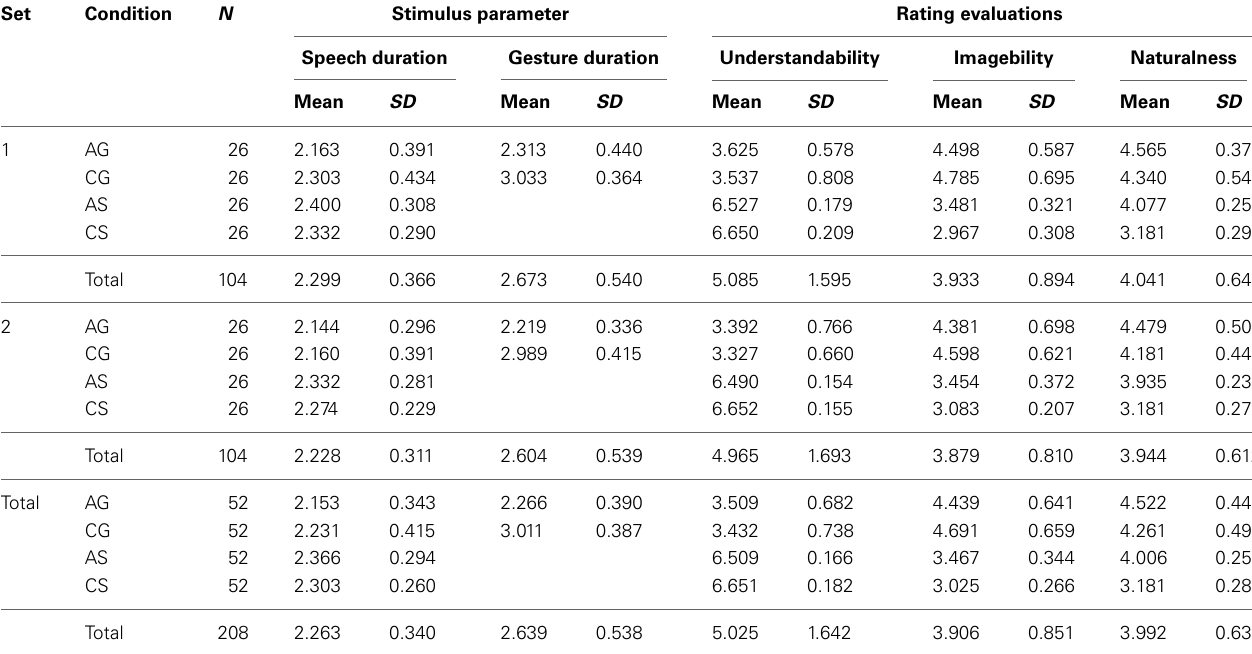
Table 1 | Number of videos and their mean durations of stimulus parameters speech and gesture as well as their mean stimulus ratings of understandability, imageability, and naturalness according to the four conditions abstract-gesture (AG), concrete-gesture